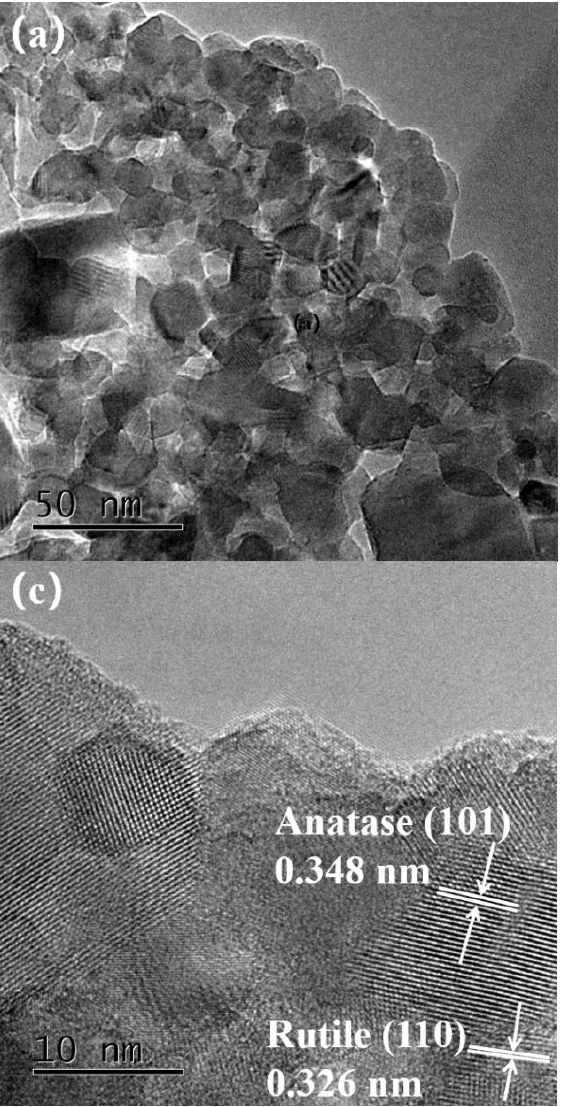
Figure 3. TEM and HRTEM images of pure TiO 2 ( a , c ) and Ag@SnO 2 /TiO 2 ( b , d ).